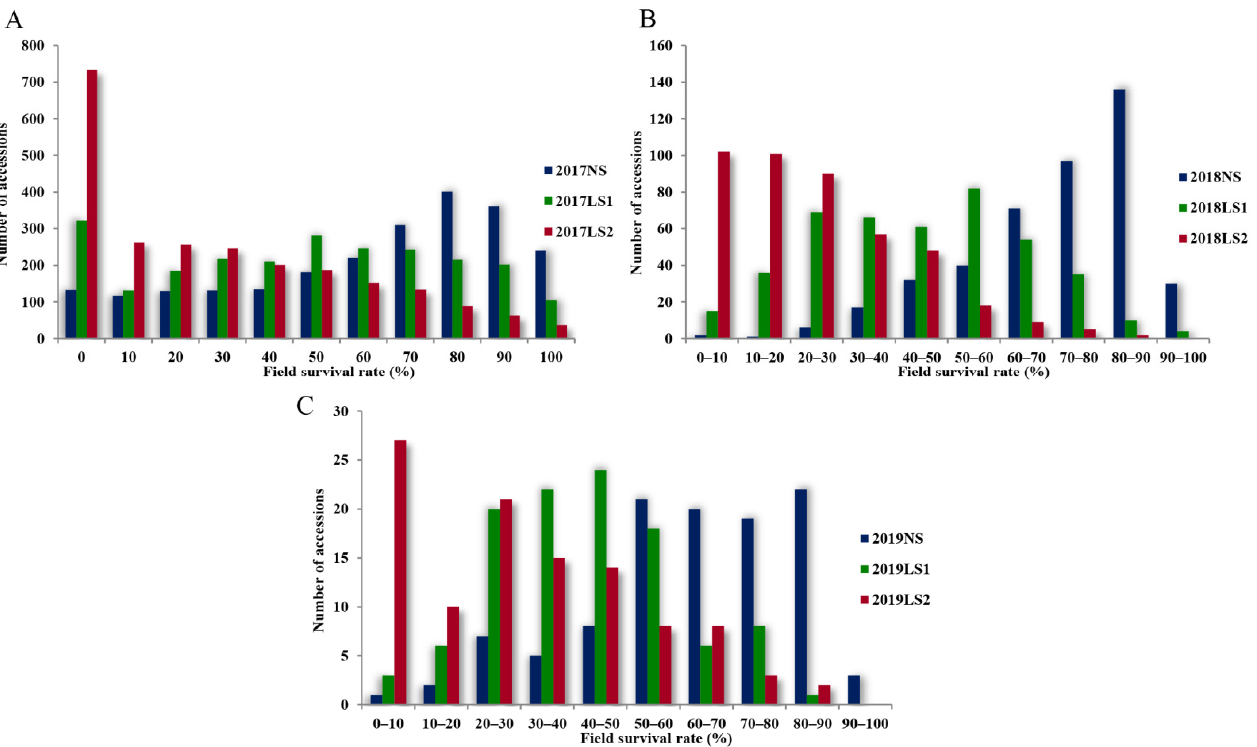
Figure 3. Distribution of FSRs of pea accessions at different sowing stages during the three heat-tolerance screenings. ( A ) HST1 in 2017. ( B ) HST2 in 2018. ( C ) HST3 in 2019. tolerance screenings. ( A ) HST1 in 2017. ( B ) HST2 in 2018. ( C ) HST3 in